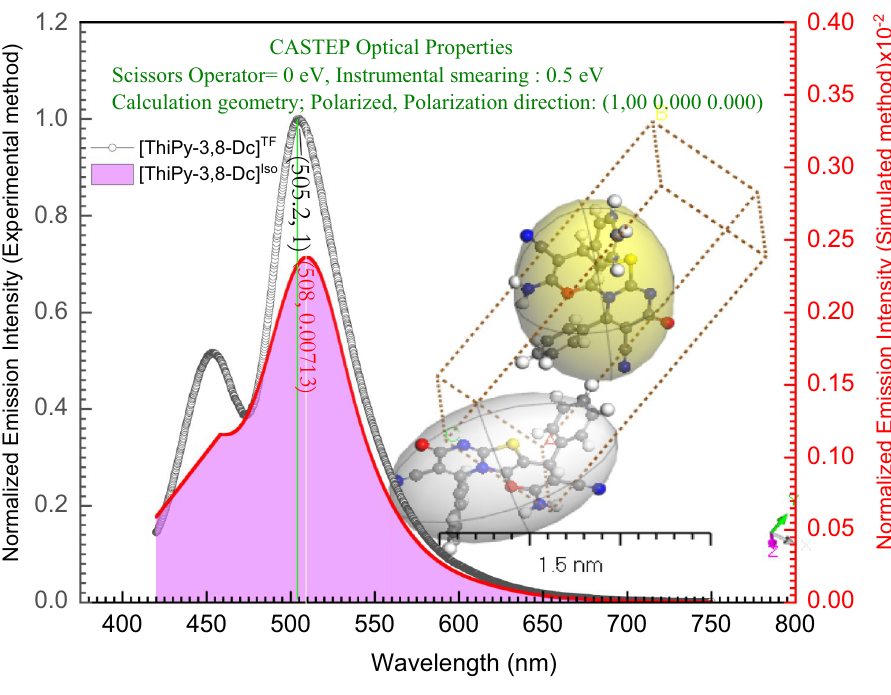
Figure 12. Combined between normalized emission spectra at λ max = 400 nm of the solid at λ max = 1 × 10 –5 M (as Experimental) and simulated by using TD-DFT/CASTEP